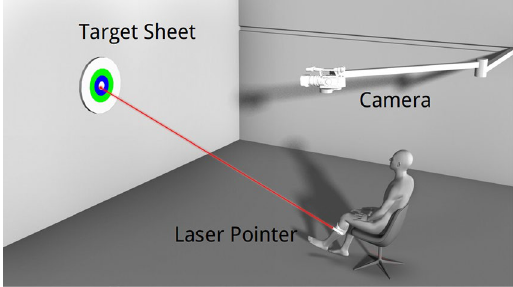
Figure 1. Schematic diagram of the knee-aiming task.participant sit on a chair or a bad with a Knee-Aiming